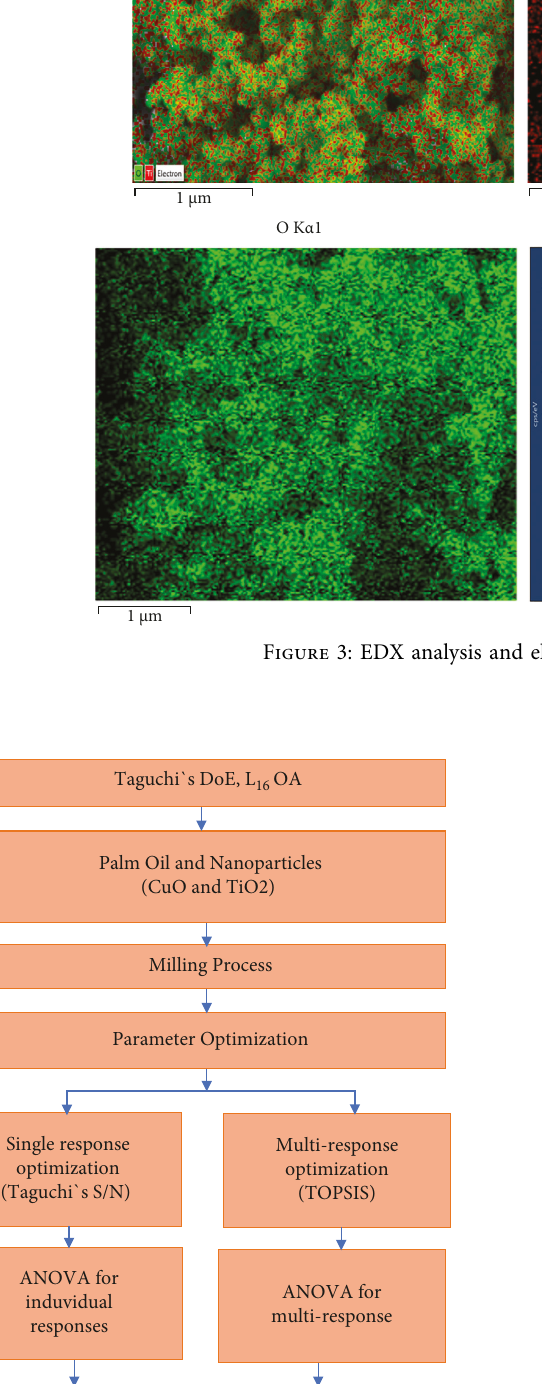
Figure 4: Flowchart for